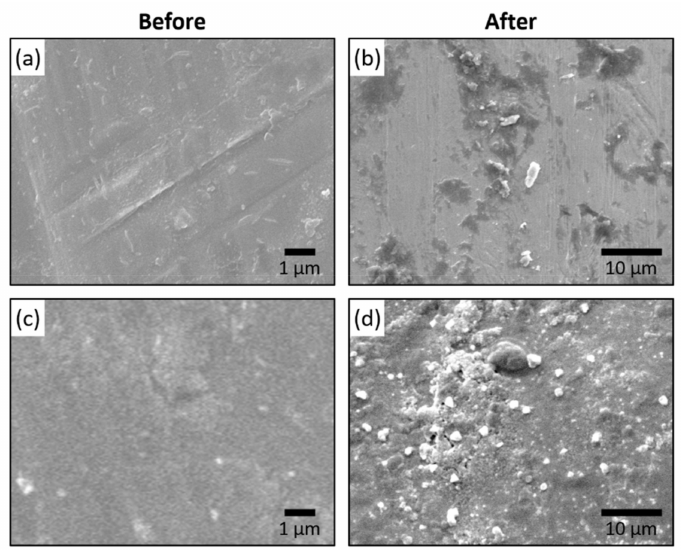
Figure 6. SEM image of surgical blade ( a ) before and ( b ) after cutting the meat sample. Ag/PDA modified surgical blade ( c ) before and ( d ) after cutting the meat